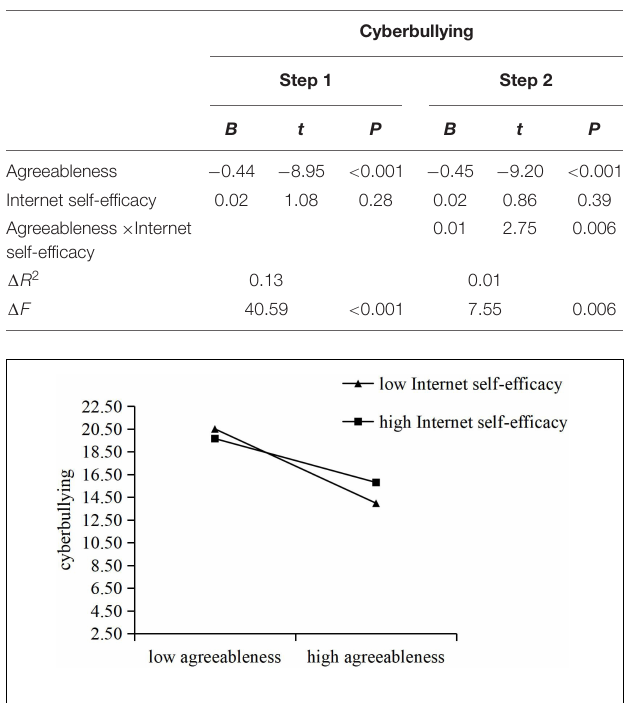
FIGURE 2 | The moderating effect of gender on agreeableness and